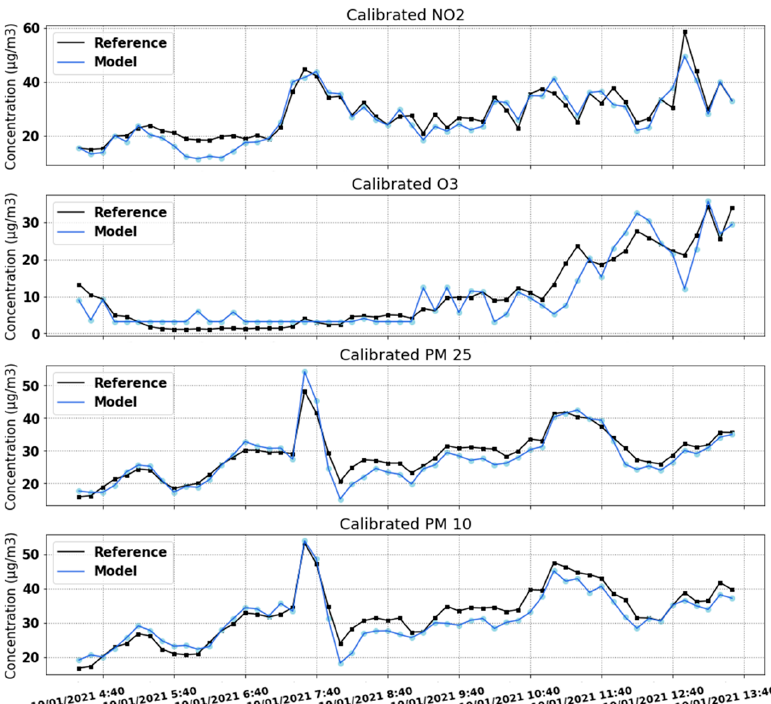
Figure 9. Calibrated data for NO 2 , O 3 , PM 2.5 , and PM 10 . Measurement unit is micrograms per cubic meter ( μ g/m 3 ).